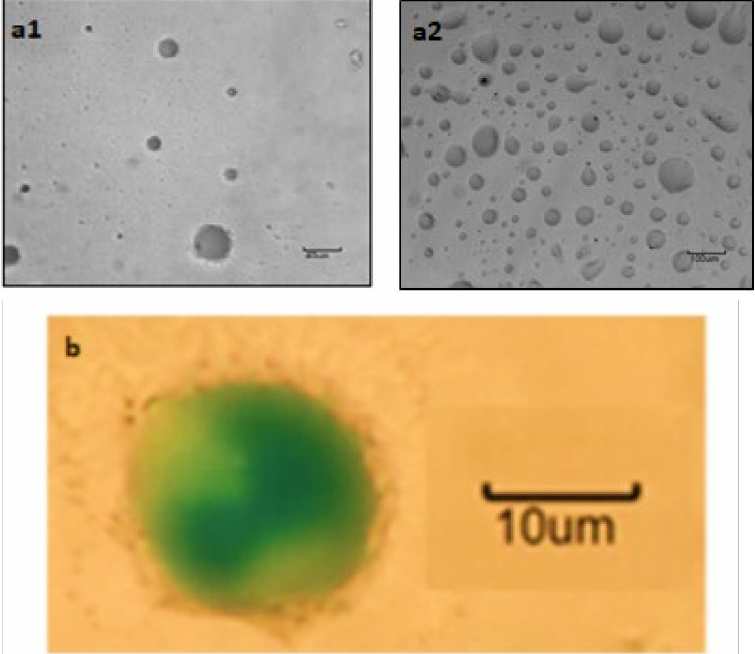
Figure 3. Optical micrographs taken during a step-by-step self-assembly of charged (anionic) gel mi- croparticles (poly(NIPAM(0.98)-AMPS(0.2)) with a linear cationic polyelectrolyte (PDAMAC): ( a1 ) after 1 step; ( a2 ) after 5 steps. ( b ) Self-assembled fused microparticle where yellow- and blue-dyed microgels are used in alternate